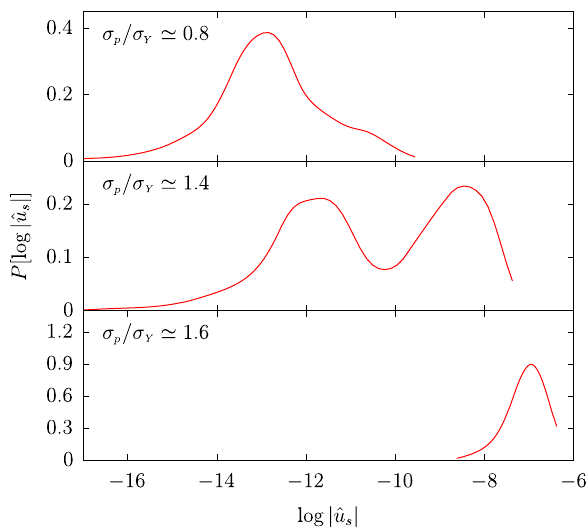
FIG. 6. Probability distribution functions for log ð Δ different values of the forcing displayed in Fig. 4. Top panel: At the smallest forcing, σ p = σ Y ≃ 0 . 8 , there is one peak at small values with a long tail over larger values indicating the inter- mittent spikes of plastic activity that the system experiences. Middle panel: At σ p = σ Y ≃ 1 . 4 , the system spends time both in the solid elastic response branch (smaller peak) and in the plastic flowing one (larger peak; see Fig. 2), so the probability distribution is bimodal. Bottom panel: At σ the fluidized state exists, signaled by the peak at large values.